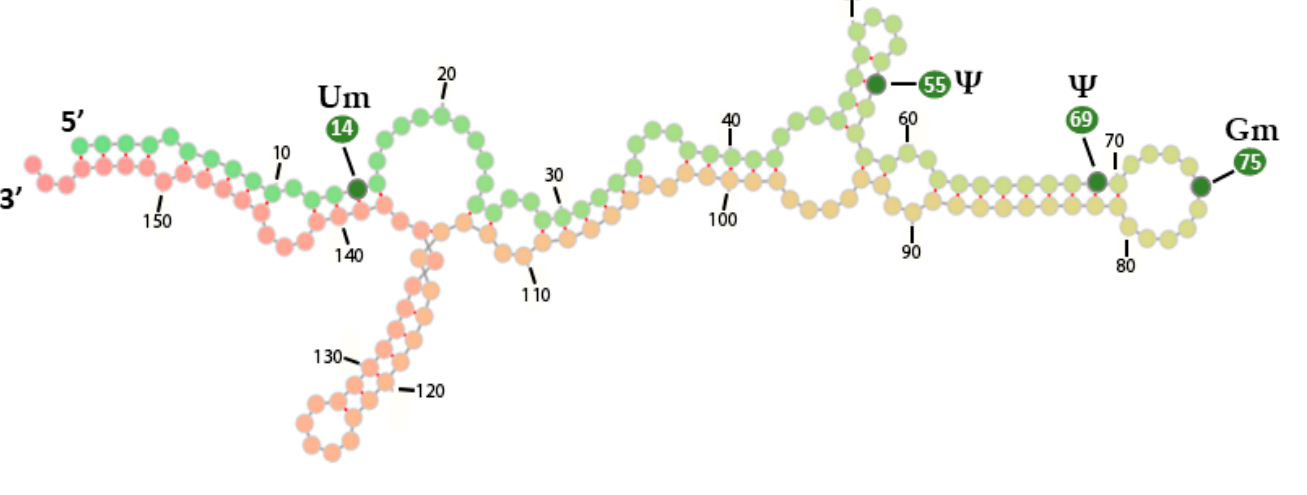
Figure 4. Schematic demonstration of the detected RNA modifications in human 5.8S RNA, as well as their respective positions in the RNA sequence.